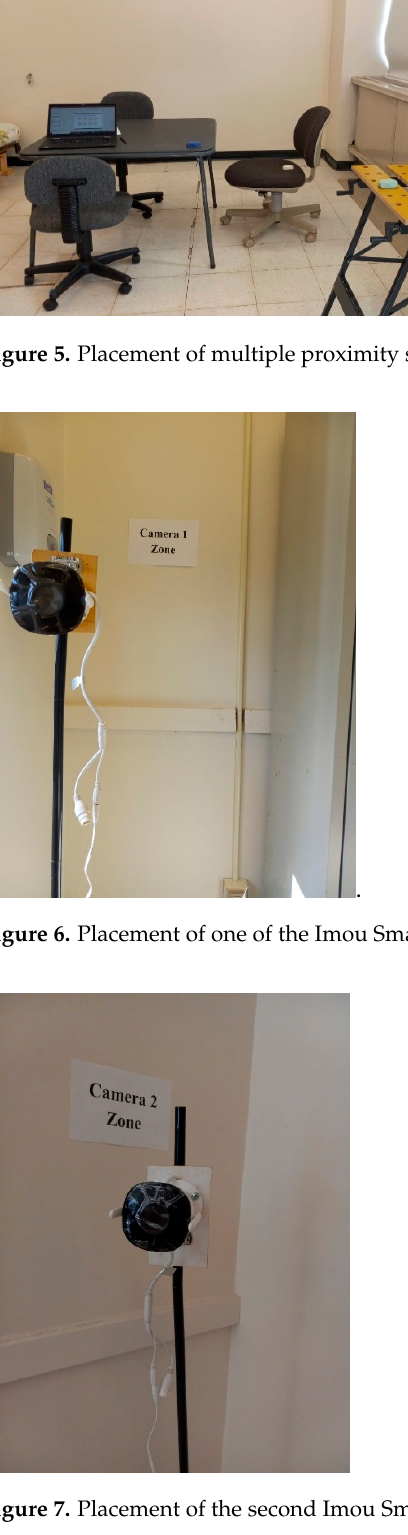
Figure 7. Placement of the second Imou Smart Camera. Table 1. Costs of the sensors that are necessary for the development of the proposed system.